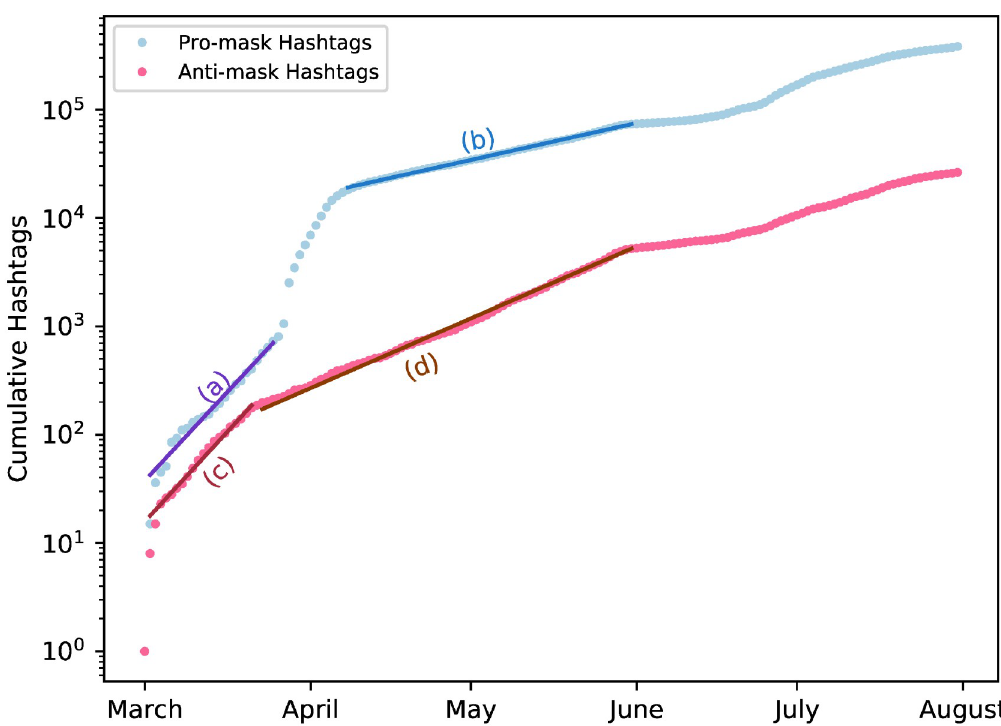
Fig 4. Exponential trends of mask-related hashtags from March 1 to August 1 2020. Fits (a-d) are best-fit exponentials with growth rate λ over a given interval; for (a) λ = 0.122/day from March 2 to March 26 with R 2 = 0.993, for (b) λ = 0.025/day from April 8 to June 1 with R 2 = 0.998, for (c) λ = 0.124/day from March 2 to March 22 with R 2 = 0.988, and for (d) λ = 0.049/day from March 23 to June 1 with R 2 = 0.998.